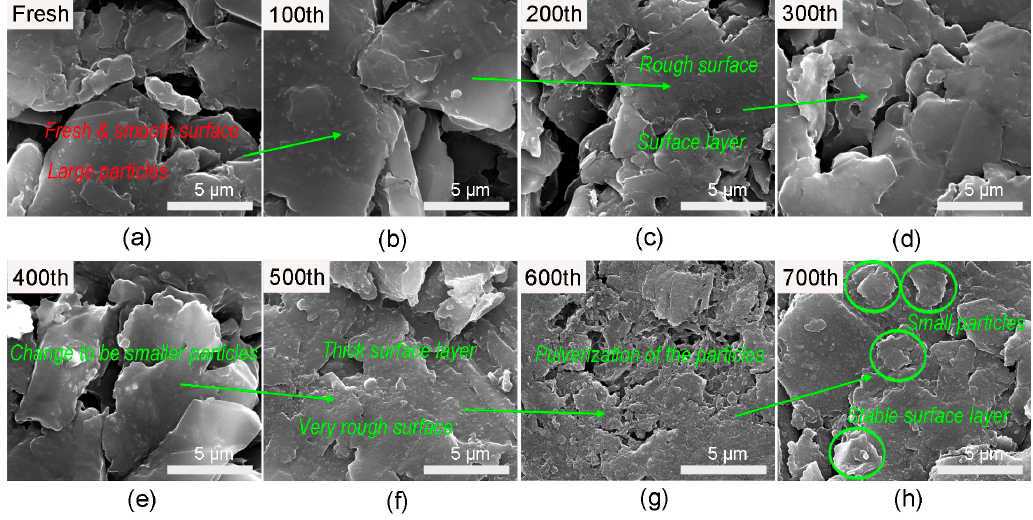
Figure 8. FE SEM images of harvested Gr anode electrodes experienced various cycles: ( a ) fresh; ( b ) 100th; ( c ) 200th; ( d ) 300th; ( e ) 400th; ( f ) 500th; ( g ) 600th; ( h ) 700th.